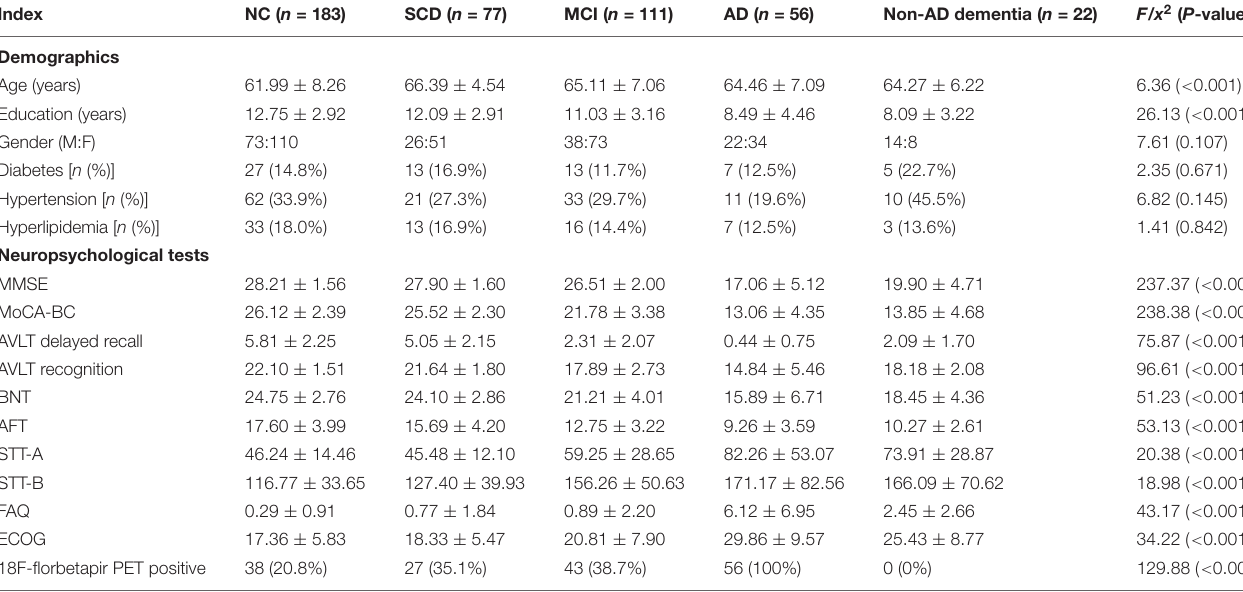
TABLE 1 | Demographics, neuropsychological tests and 18F-florbetapir PET imaging for NC, SCD, MCI, AD, and non-AD